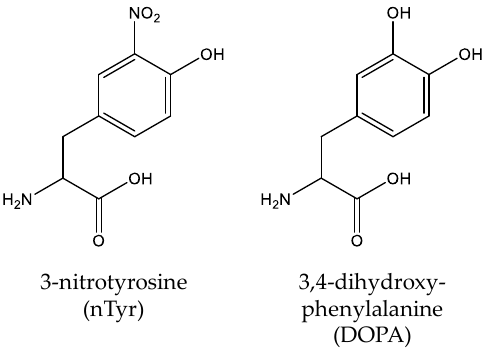
Figure 8. The structures of other modifications of tyrosine, including 3-nitro-tyrosine (nTyr) and 3,4-dihydroxy-phenylalanine (DOPA).